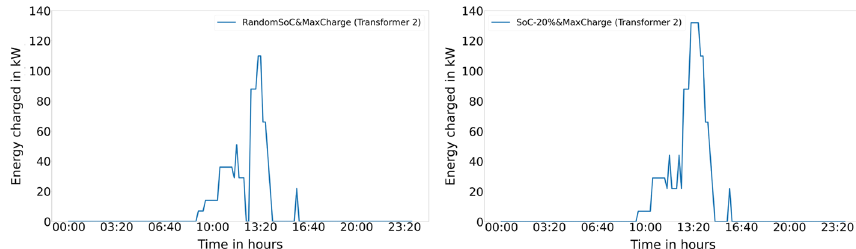
Fig. 12 Power profiles of transformer 2 for the baseline scenario with randomized (left) and 20% (right) SoC under the MaxCharge